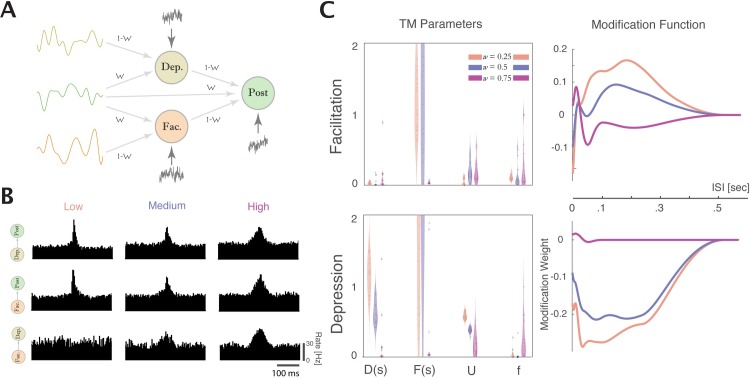
Common input can prevent accurate estimation of STP.A) We simulated a microcircuit where, rather than receiving independent input, the presynaptic and postsynaptic neuron both receive correlated, common input. We use three different sources of fluctuating input to each of the three LIF model neurons, varying the strength of common input. B) Cross-correlograms for three levels of common input (w = 0.25, 0.5, 0.75). C) Left panels: TM parameters estimated from spiking of neurons with (from left to right) low, medium, and high common input. Right panels: GBLM modification functions for the facilitating (top) and depressing (bottom) synapses and the three different levels of common input.